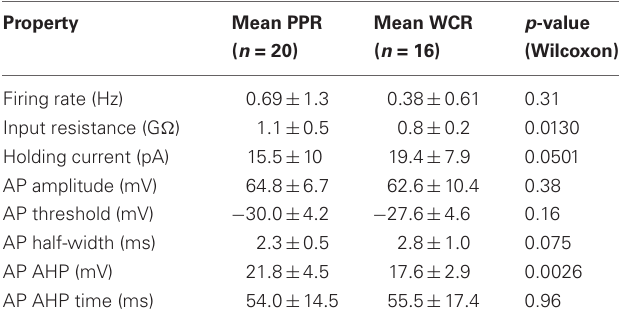
Table 1 | Summary baseline intrinsic properties of V2a INs using PPR and WCR.